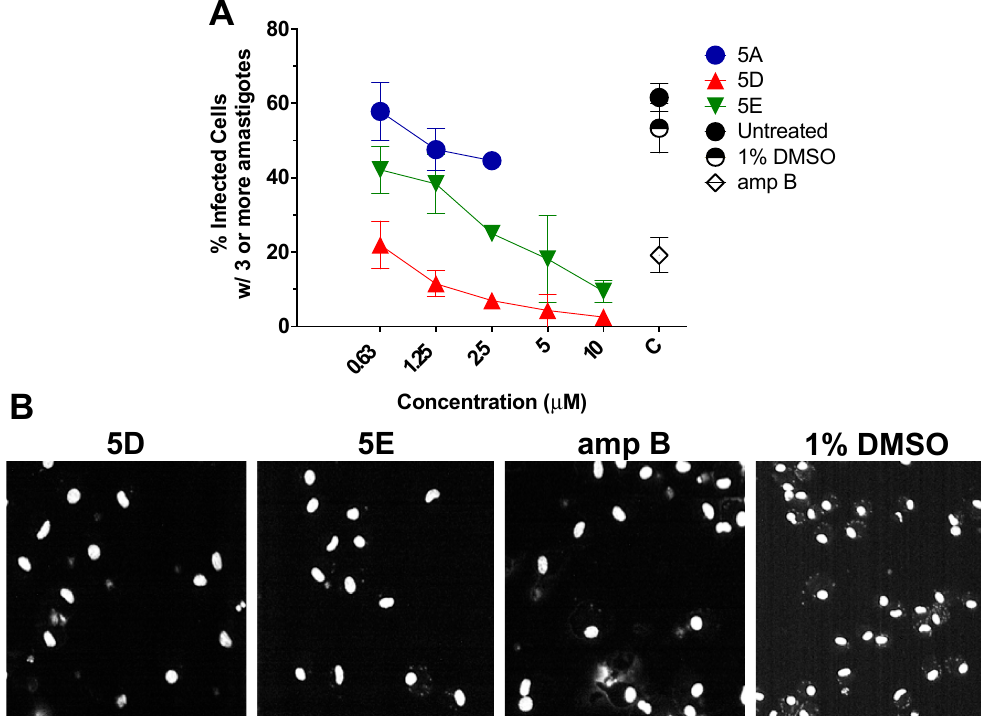
Figure 5. ( A ) High content imaging assay (HCIA) analysis of intraperitoneal mouse macrophages (IP Φ ) infected with L. major-luc amastigotes, followed by treatment with 5D or 5E from 0.63 to 10 µM for 48 h. Controls included untreated, 1% DMSO, amphotericin B (amp B) at 5 µM, or parent drug 5A . Data are represented as the percentage (%) of infected IP Φ with three or more amastigotes per cell. Note: Data for 5A at concentration 5 and 10 µM were not generated because 5A was cytotoxic for IP Φ at such concentration. ( B ) Representative monochromatic images of infected IP Φ with L. major after 48 h treatment with 5D or 5E at 2.5 µM, amp B (5 µM), or 1% DMSO.